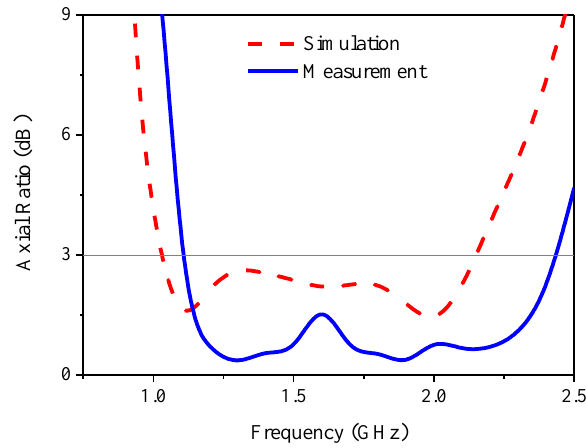
Figure 19. The simulated and measured axial ratio of the proposed antenna.